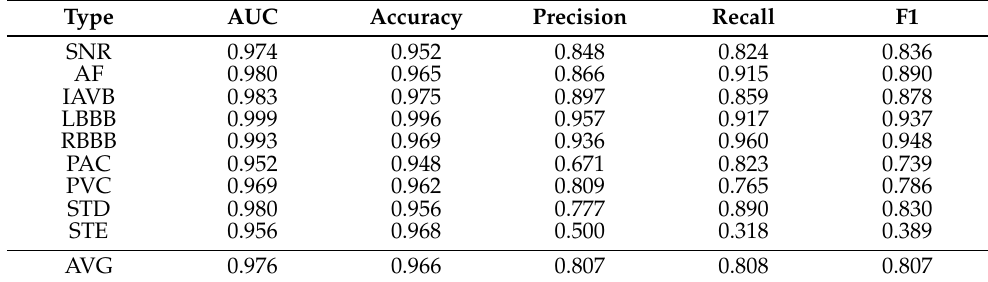
Table 6. Classification performance with the random auxiliary task on the CPSC2018 dataset.